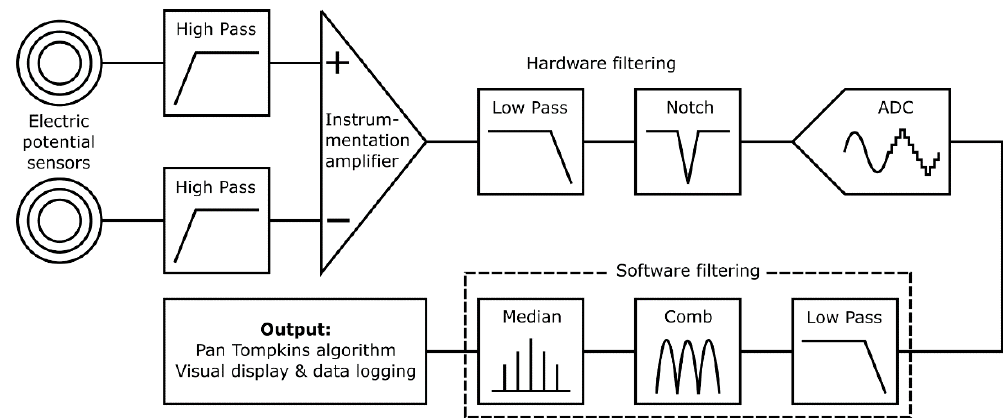
Figure 2. Prototype system signal path with input, filtering and output stages identified.